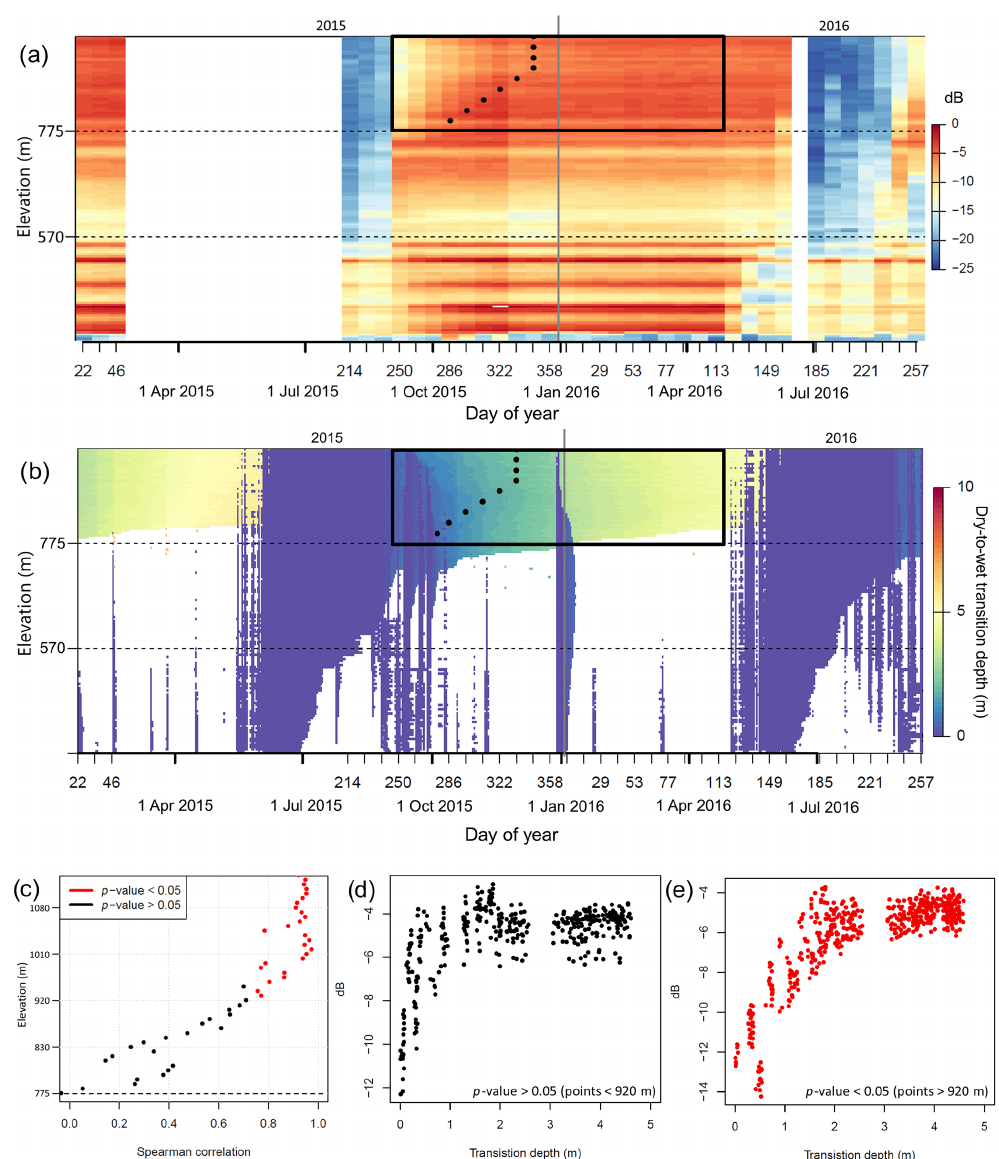
Figure 7. The figures show results from Holtedahlfonna (a) Sentinel-1A SAR backscatter (dB) time series from 22 January 2015 to 13 September 2016 (DOY 22 2015 to 257 2016). Black points indicate where the backscatter stabilizes in the cold season. (b) Daily modeled water content for each 300m point along a centerline profile and the transition depth (in meters) between wet snow and firn (water con- tent > 0) and dry snow and firn (water content = 0). The white regions in the plot indicate no water since it is glacier ice with no snow in the summer or with dry-snow conditions in the winter. Transition depth of 0m indicates wet-snow conditions on the surface. (c) Spearman correlation between depth of dry-to-wet transition zone and backscatter values plotted with elevation ( y axis) in firn area above 775m. We used a time period with stable conditions: 7 September 2015 to 22 April 2016 (DOY 250 2015 to 113 2016; black box in panels a and b ). Sig- nificant correlation values (after Bonferroni multiple testing correction) are plotted in red. (d) Plot of backscatter values (dB) vs. dry-to-wet transition depth (layer) for points in (c) with p value > 0.05 (points under ∼ 920m, using the same time period of 7 September 2015 to 22 April 2016, DOY 250 2015 to 113 2016). The correlation coefficients are 0.266 (Pearson’s correlation coefficient) and 0.3 (Spearman rho). (e) Plot of backscatter values (dB) vs. dry-to-wet transition depth (layer) for points in (c) with p value < 0.05 (points above ∼ 920m, using the same time period as in c and d ). The correlation coefficients are 0.834 (Pearson’s correlation coefficient) and 0.725 (Spearman rho).